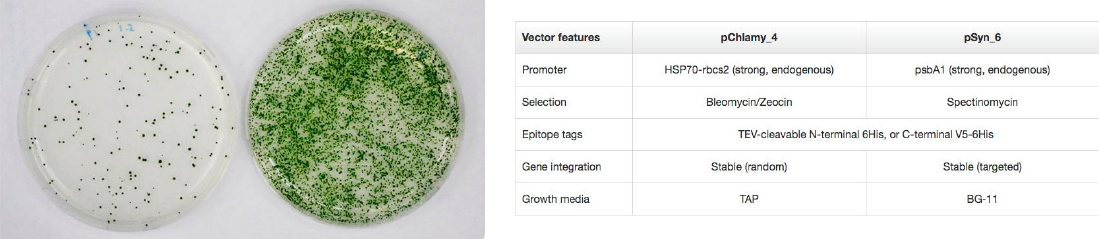
Figure 1. ( Left ) Transformed S. elongatus growing in BG-11 agar plates containing spectinomycin (5 µg/mL). Negative control with no insert ( Left ) and containing the bird cathelicidin peptide Mm_KR-26; ( Right ) Comparison of the microalga vectors pChlamy_4 and pSyn_6 (ThermoFisher) used for the recombinant expression of cathelicidin antimicrobial peptides into the microalga C. reindhartii and S. elontgatus , respectively.